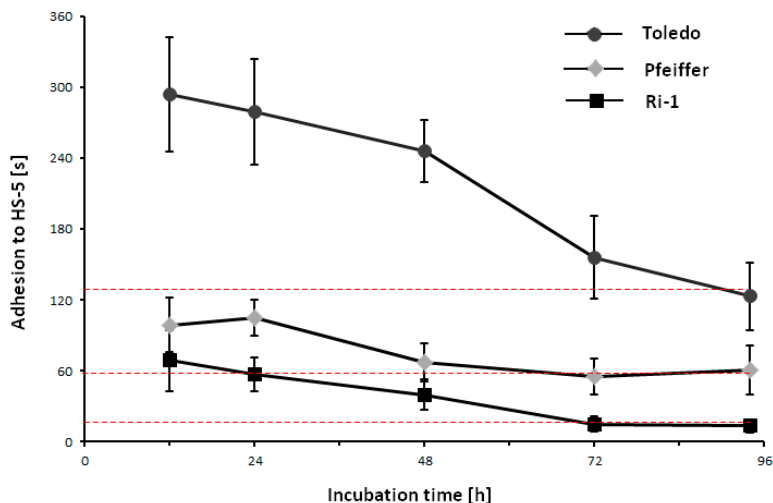
Figure 7. Adhesion changes of single lymphoma cells to mesenchymal stromal cells evaluated in optical tweezers in time-scale for Ri-1, Pfeiffer, and Toledo cells during the reoxydation process. Evaluations were made at 24, 48, 72, and 96 h from the beginning of the cell incubation in normoxia. Data are representative of 10 measurements for each cell line at each time point ± S.D. Red dotted lines indicate the average contact time required for the formation of adhesion between lymphoma cells and mesenchymal stromal cells which is 15.5, 55.9, and 132.9 s for Ri-1, Pfeiffer, and Toledo cells, respectively.